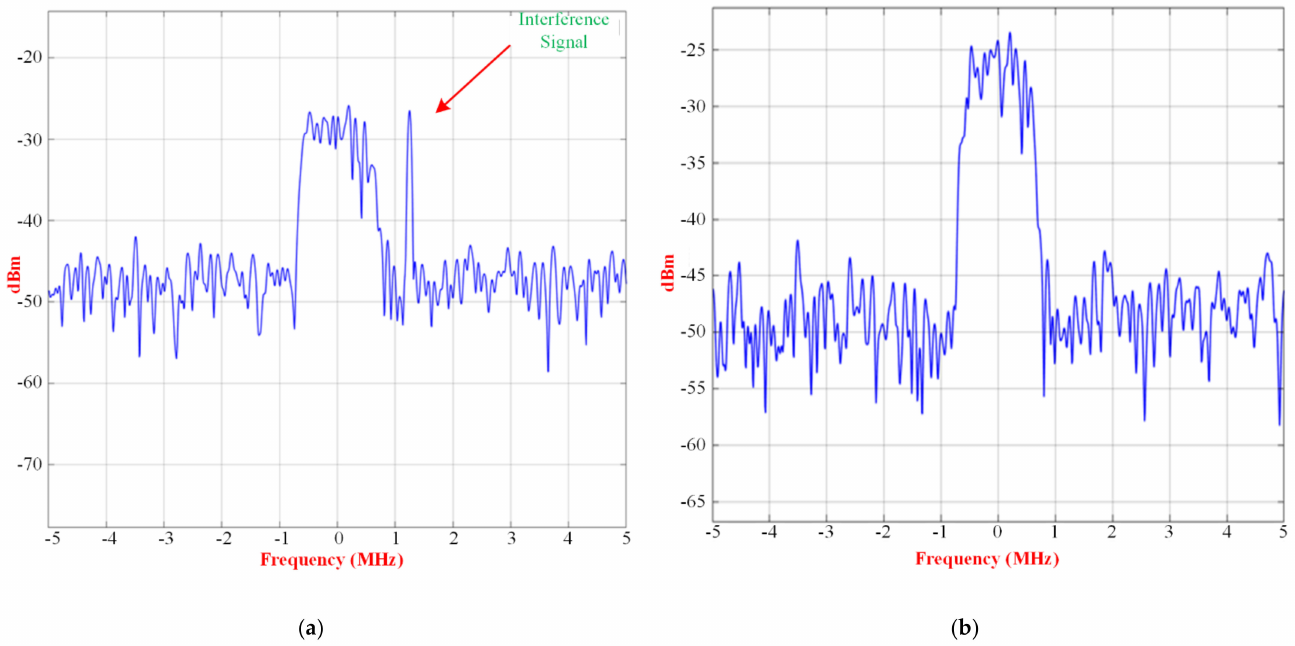
Figure 27. Signal and interference input spectrum of the RF receiver for case 3 ( a ) without beamform- ing, and ( b ) with